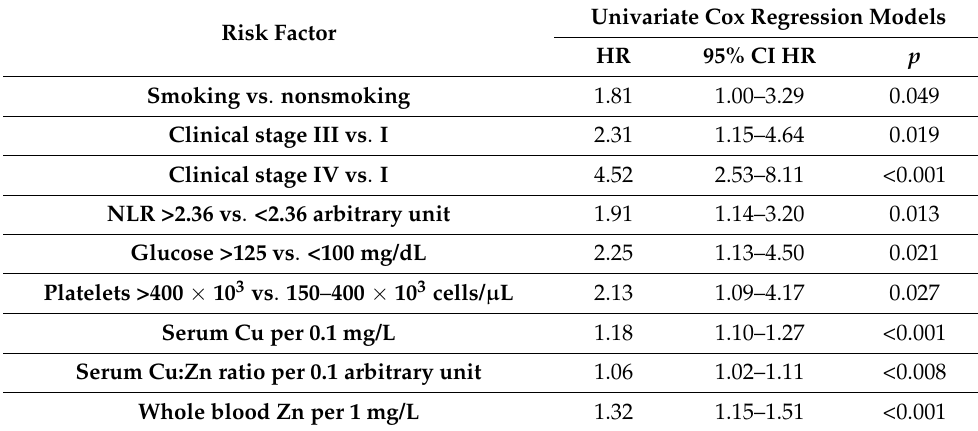
Table 3. Univariate Cox regression models predicting lung cancer mortality.